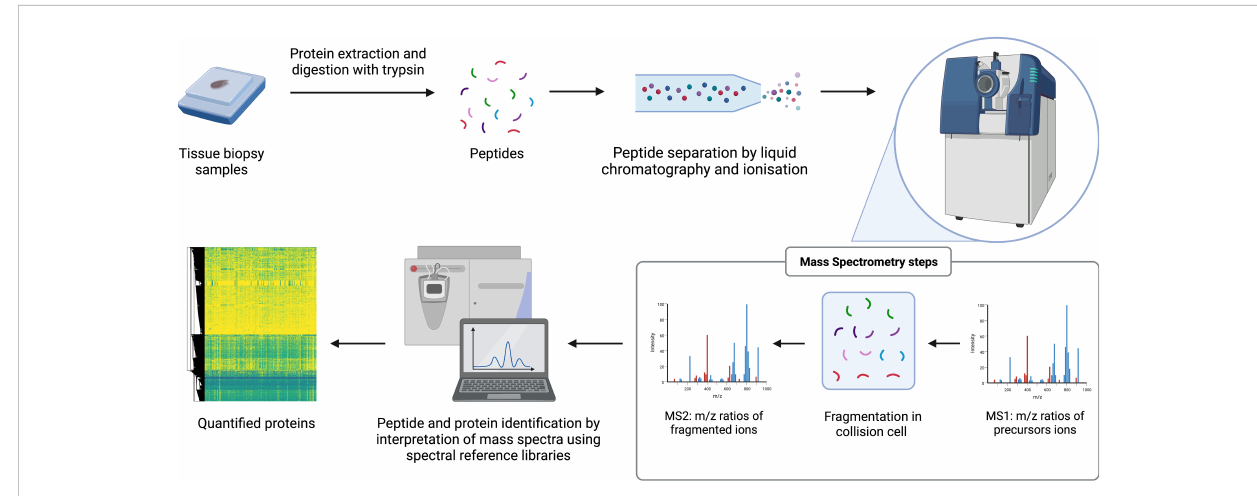
FIGURE 1 General work fl ow for label-free MS-based proteomics. The arrows re fl ect the stages of the work fl ow. e.g. starts with